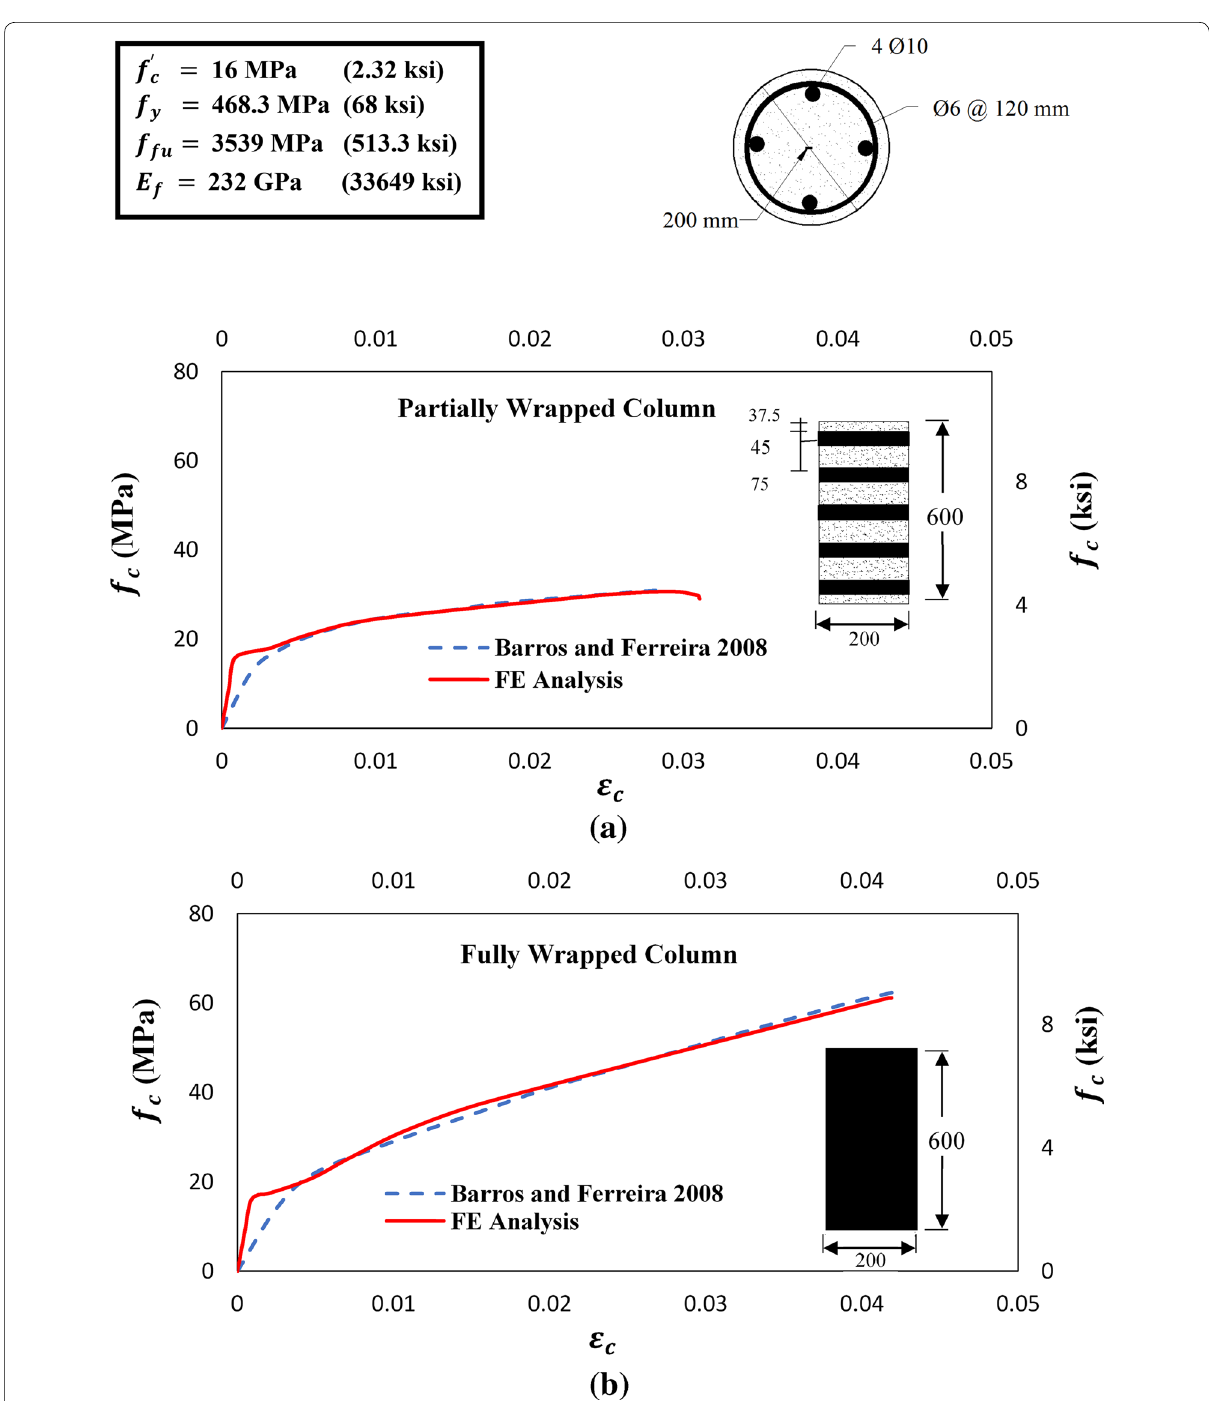
Fig. 1 Comparison of compressive stress ( f c ) versus axial strain (ε c ) between FE and experimental results: a partially wrapped column and b fully wrapped column (all dimensions are in mm; 1 mm 0.039 =